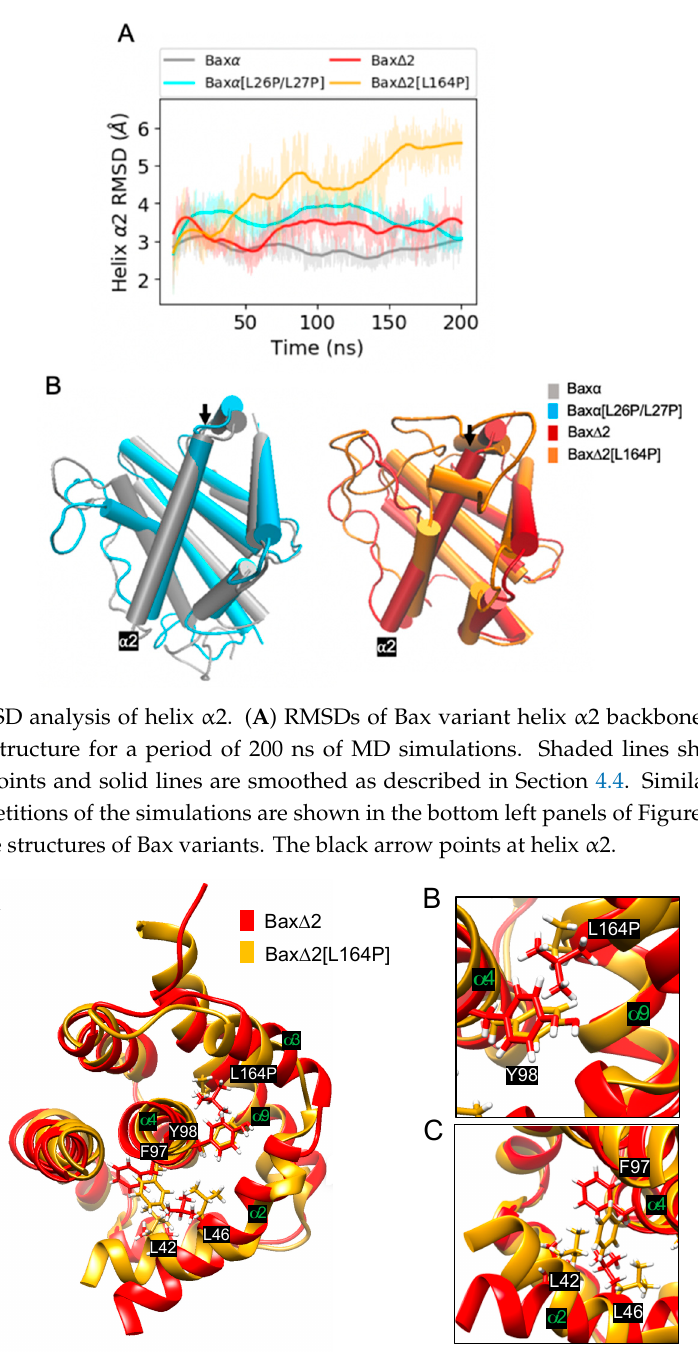
the initial structure for a period of 200 ns of MD simulations. Shaded lines show RMSDs for all recorded points and solid lines are smoothed as described in Section 4.4. Similar plots for two additional repetitions of the simulations are shown in the bottom right panels of Figures S2 and S3. ( B ) Representative structures of Bax variants. The black arrow points at helix α 9.